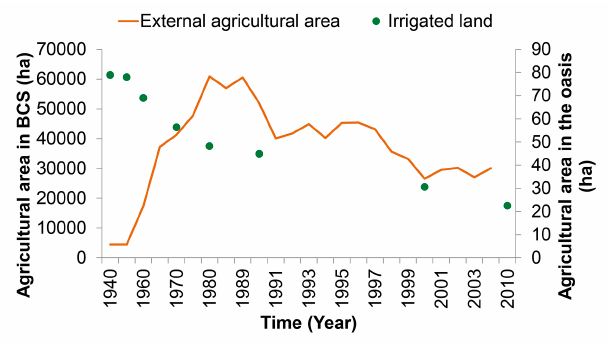
Fig. 7 . The external agricultural area in Baja California Sur (BCS) versus the irrigated land in the oasis of Comondú. The orange line indicates the external agriculture; green points denote irrigated land. Source: Urciaga (2008), in-depth interviews, and GIS (fieldwork).